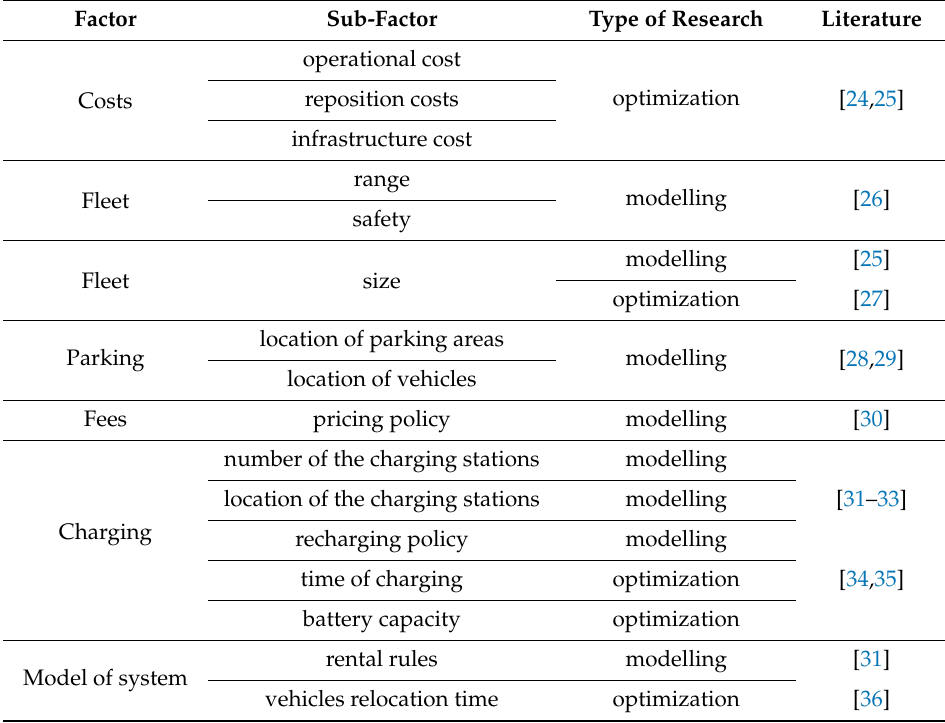
Table 2. Factors that are taken into account when modeling and optimizing electric car-sharing systems—a literature review.